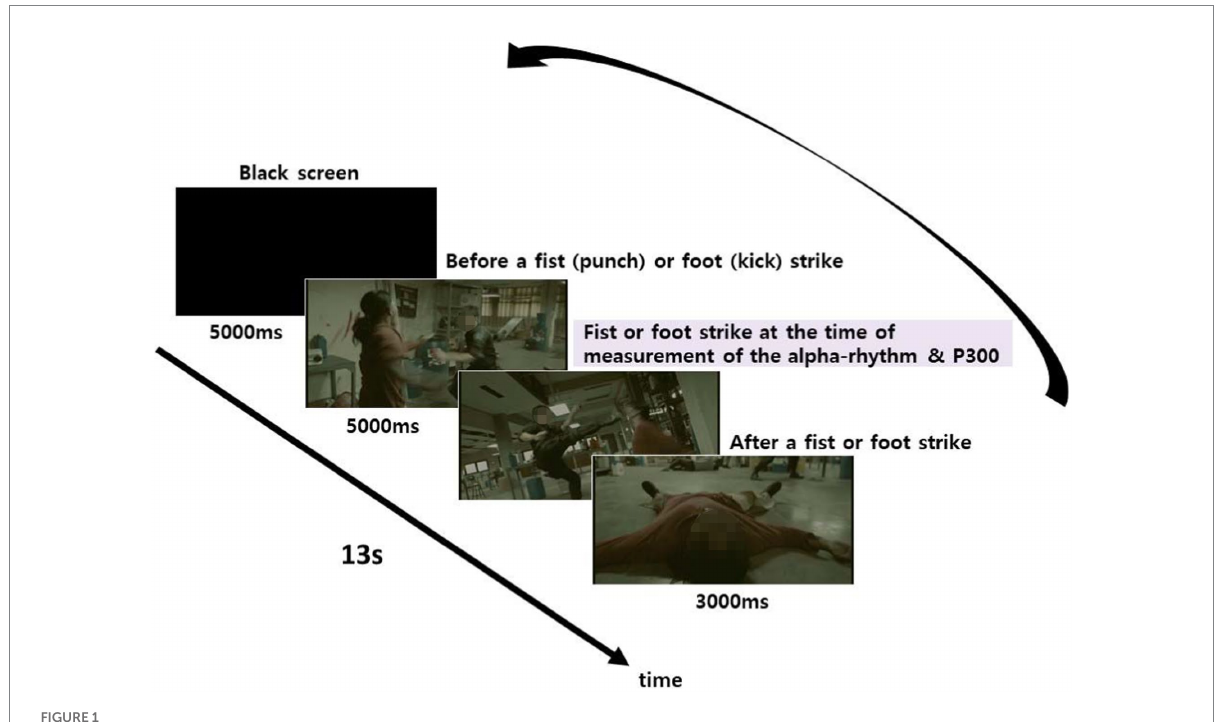
FIGURE 1 Video composition for individual